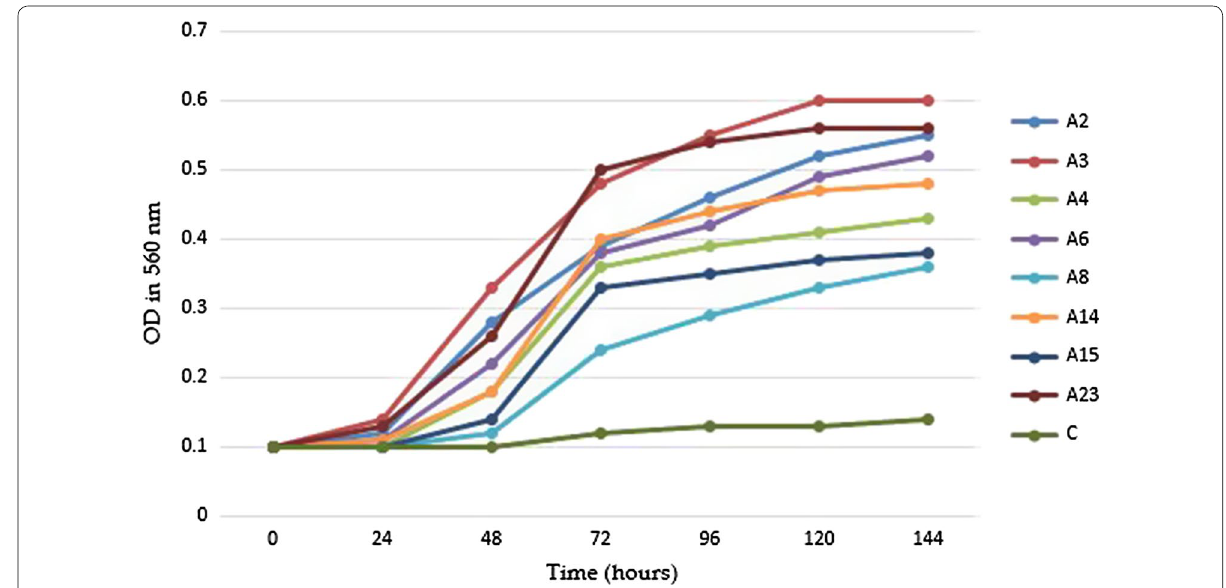
Fig. 3 Growth curves of Iranian isolates of mycobacteria over a 24 h. Incubation period at 30 °C in the presence of